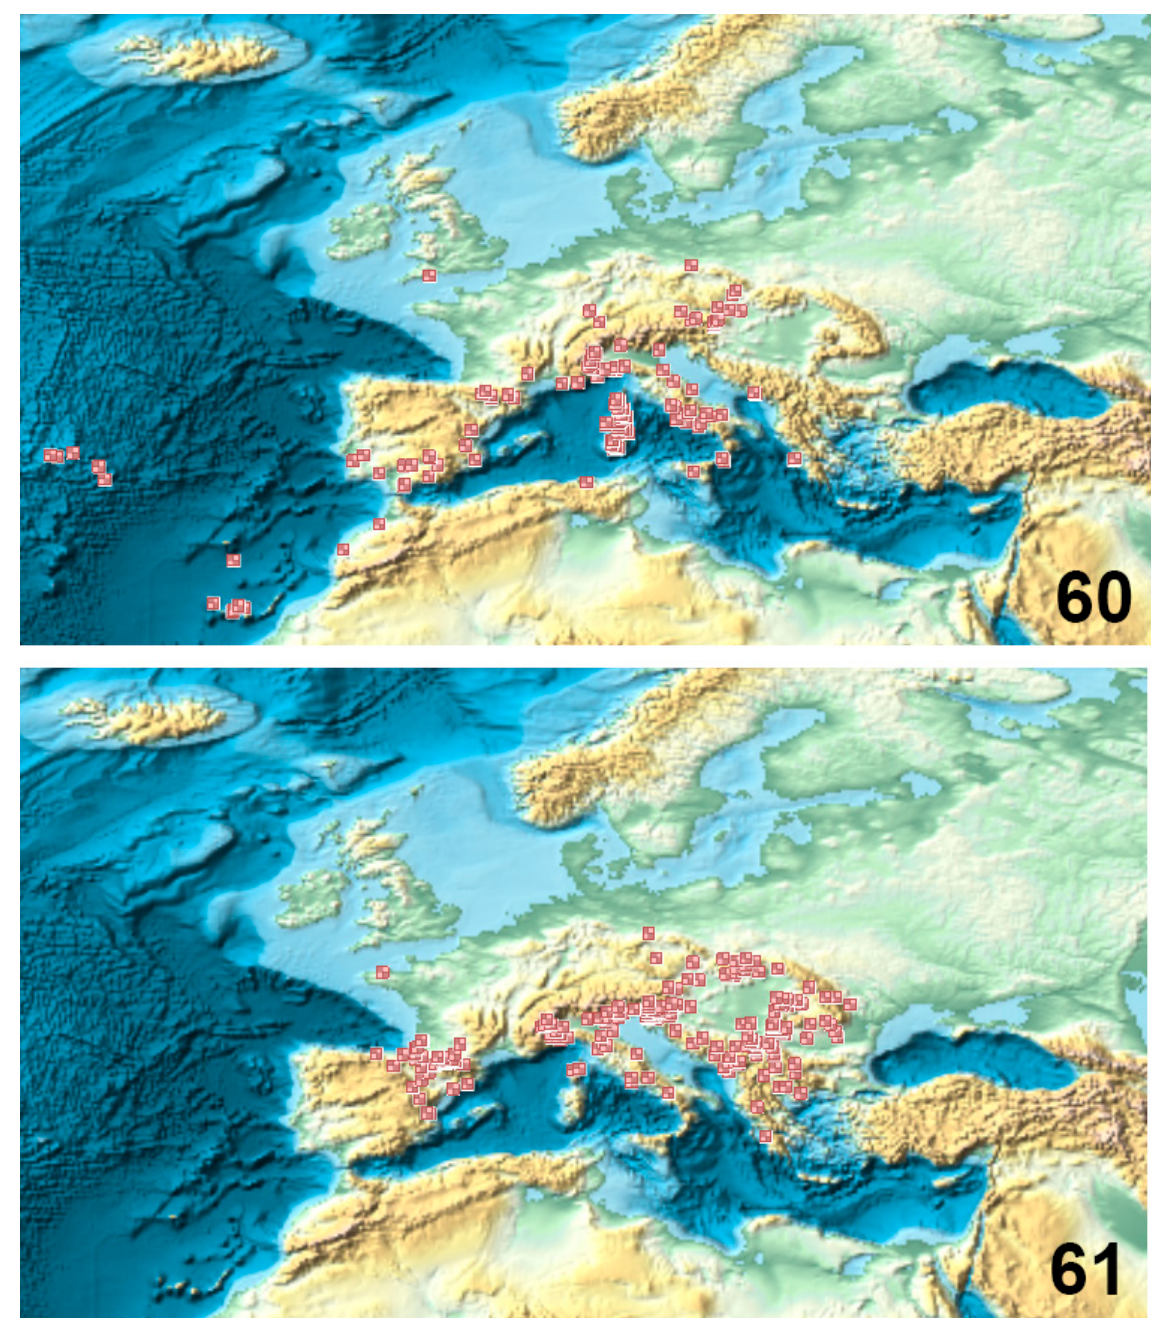
Figs 60–61. Distribution in the Euro-Mediterranean region, including Azores and Canaries. 60 . Subgenus Monocampa Silvestri, 1932. 61 . Subgenus Paurocampa Silvestri,